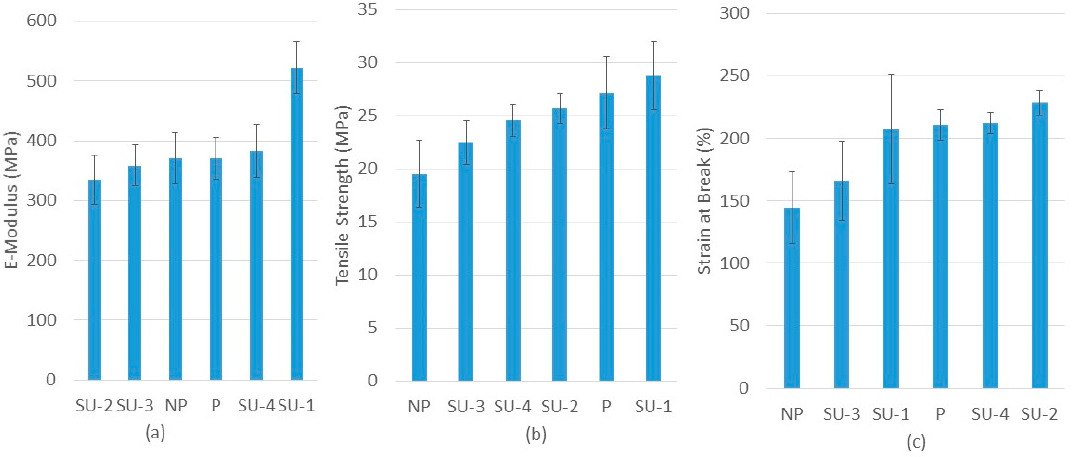
Figure 9. Results of the tensile test. ( a ) E-modulus; ( b ) tensile strength; and ( c ) strain at break. From the tensile strength values, sample SU-1 also showed the highest value of 28.77 From the strain at break, samples SU-1, SU-2, SU-4, and P showed comparable values ± 3.2 Mpa, while sample NP showed the lowest value of 19.54 ± 3.16 Mpa. The tensile in the strain at the break due to the overlapping of standard deviations. Samples NP strengths of all the printed and de-inked samples are comparable, as depicted by the over- lapped standard deviations.